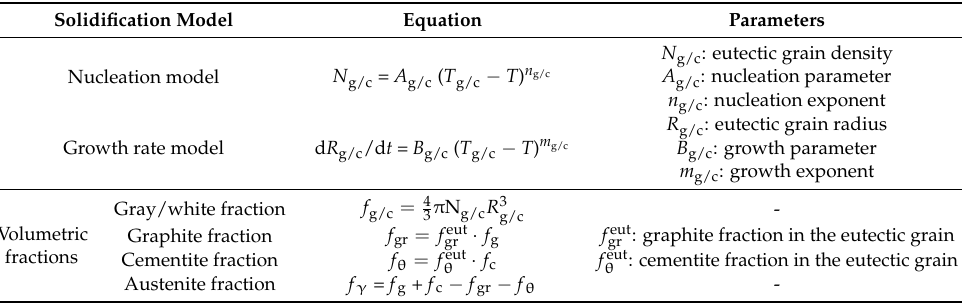
Table 3. Solidification model and volumetric fractions.